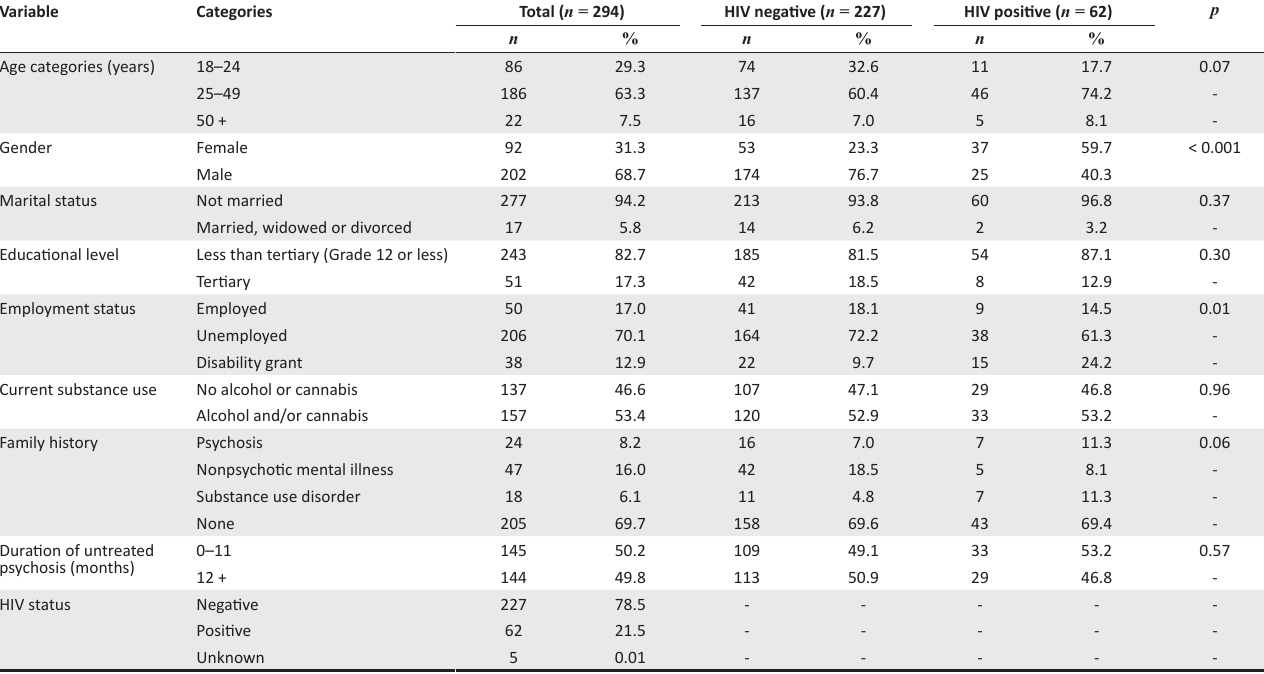
TABLE 1: Sociodemographic and clinical profile based on known HIV status in people with recent onset psychosis.